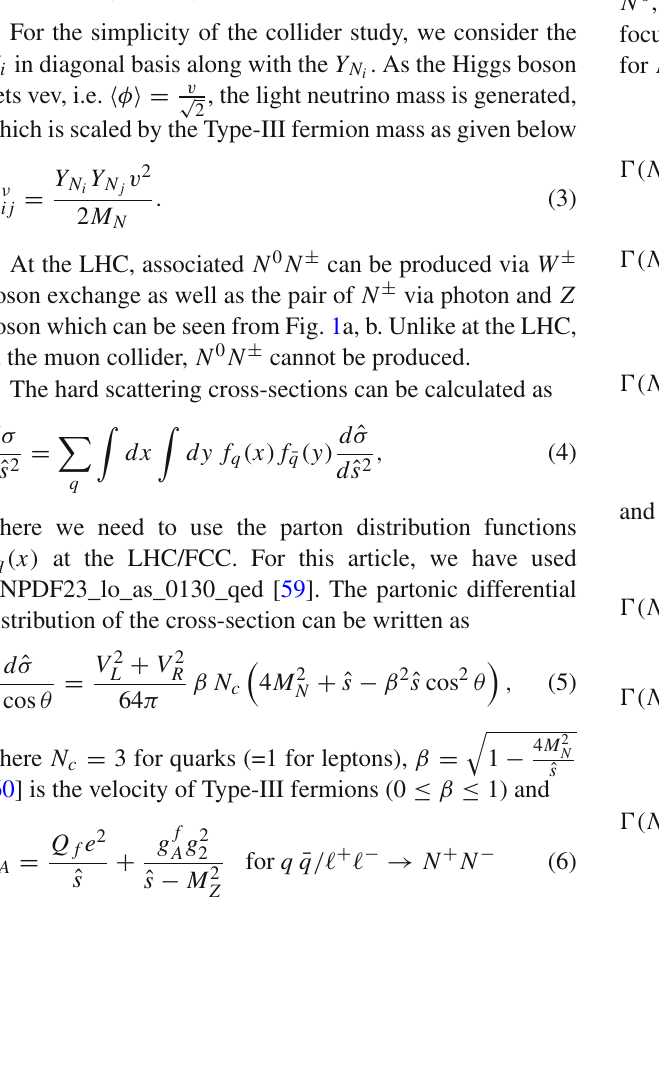
doublet. Here G ± and G 0 are charged and neutral Goldstone bosons, h is the physical Higgs boson and v is the vacuum expectation value (vev) which generates the mass for the SM particles. In Sect. 2, we use represented by Eq. (2). N i has one pair of charged fermion ± ) and one neutral component ( N 0 ( N i ( i = 1 , 2 , 3)